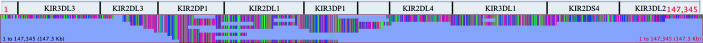
Alignment of assembled haplotigs with reference haplotype sequence MN167513 (cA01~tA01), whose length is 147,345. The gene features are annotated across the top. The haplotigs are stacked below and colored by nucleotide.